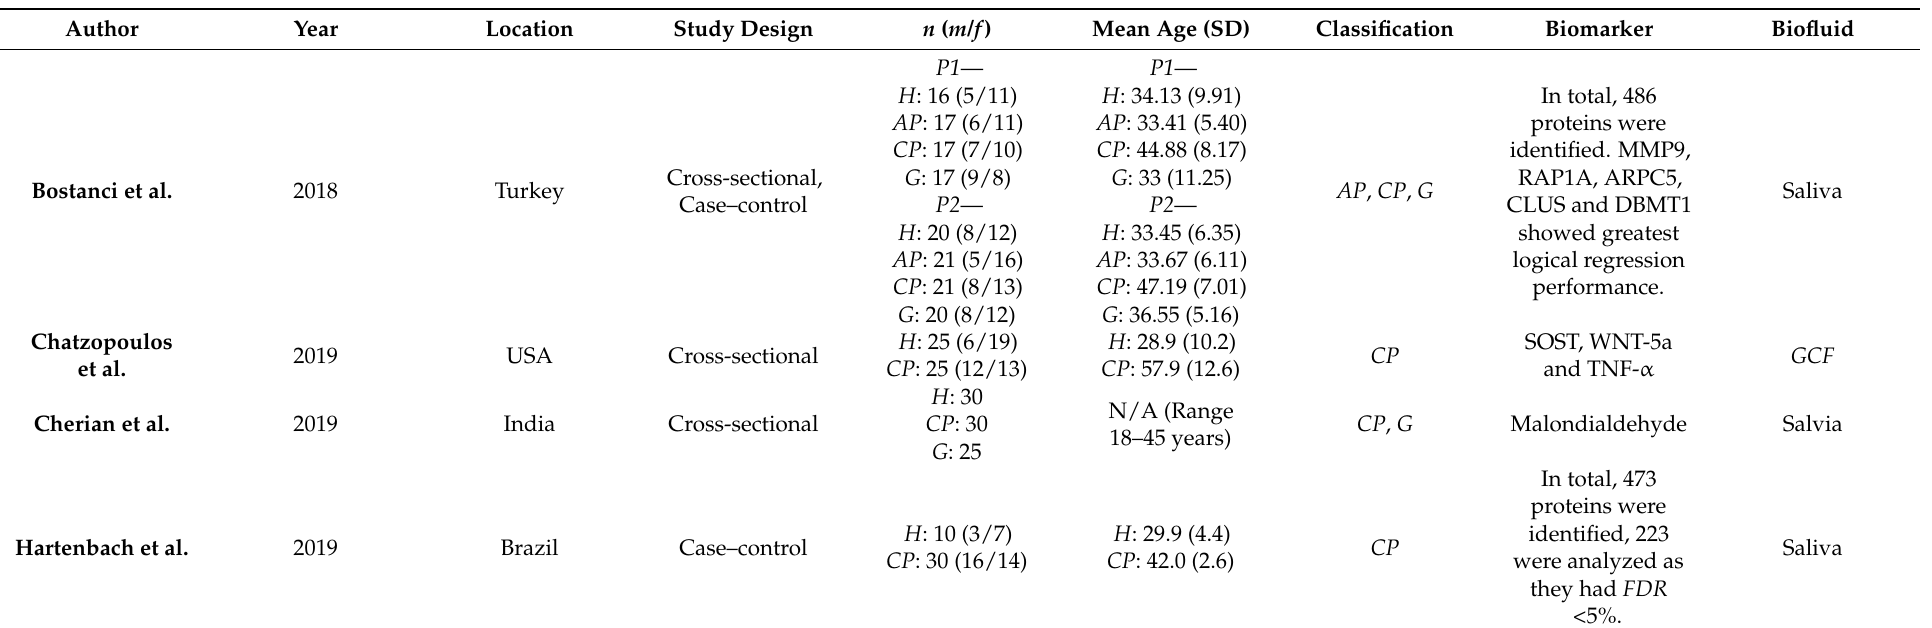
Table 3. Base-line characteristics of studies analyzing protein-based biomarkers in oral